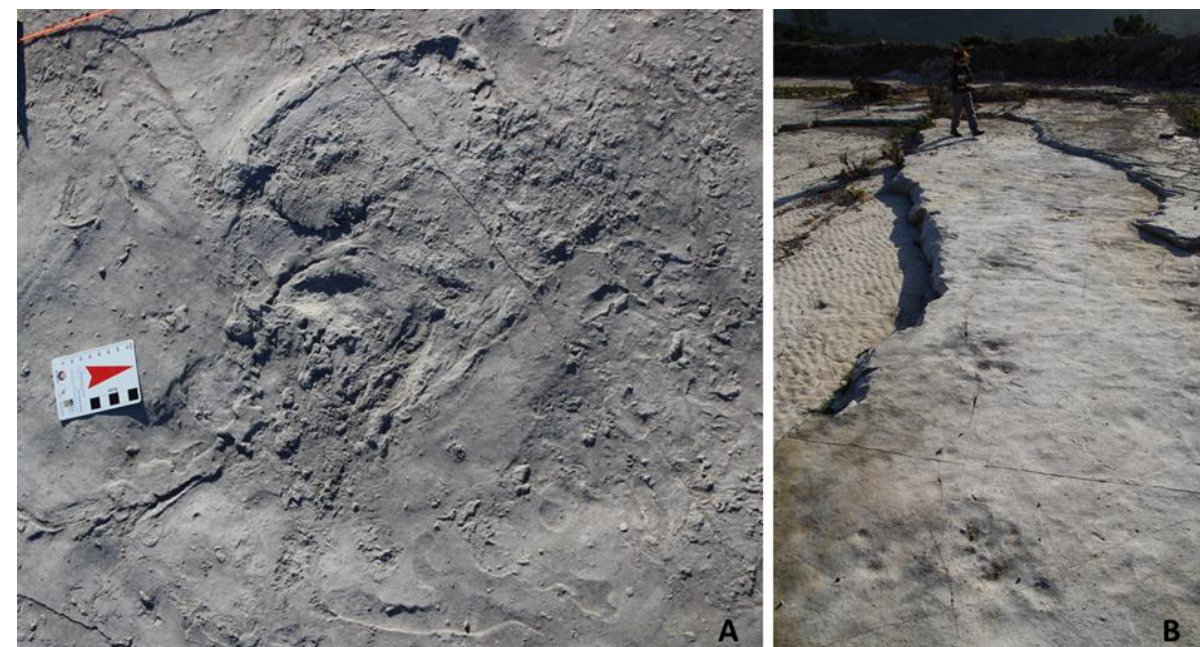
Figure 4. Resting trace of a Rhinobatidae. ( A ) The earliest example of behavior among batoids, where Cabeço da Ladeira shows a high density of feeding pits together with swimming trails, and ( B ) regurgitates attributed to this ancestral clade of the Rajiformes (photos from the authors).